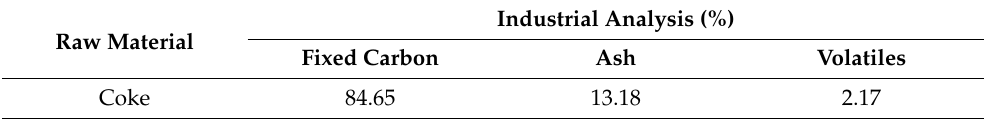
Table 3. Composition analysis of coke